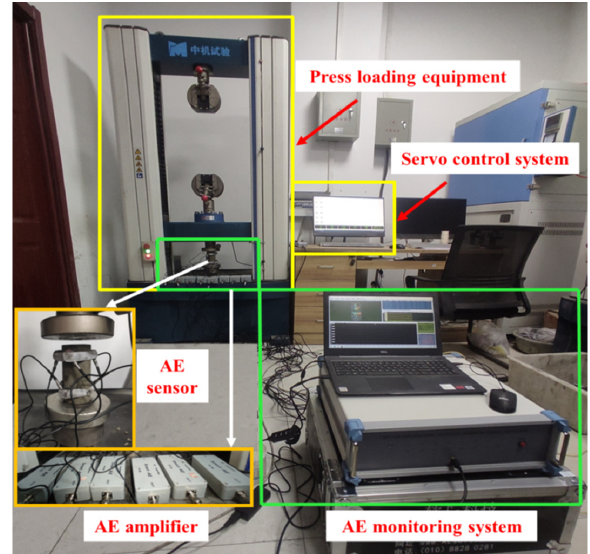
Figure 2. Experiments test system.